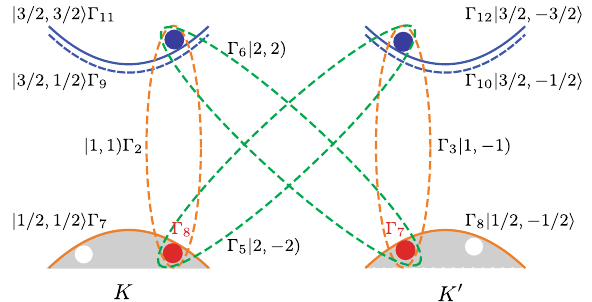
Fig. 1 Band structure of ML tungsten dichalcogenides at the K and K 0 valleys and related excitons. Valley states and excitons are denoted by irreducible representations of the C 3 h double group with the corresponding spin states shown beside. Blue, white, and dark red balls depict conduction electrons, missing valence band electrons, and holes, respectively. Bright and dark excitons are represented by orange and green dashed ovals, respectively, incorporating corresponding electrons and